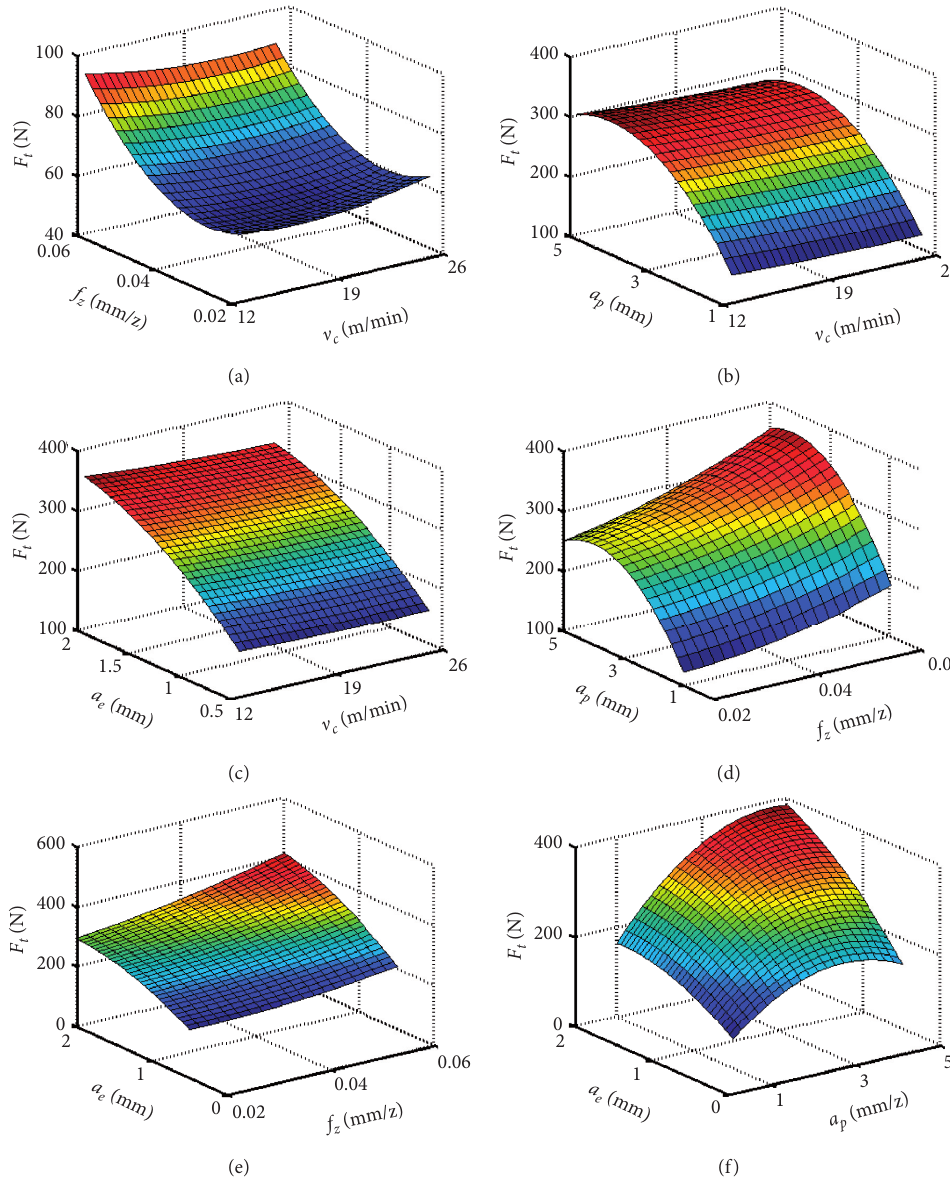
Figure 3: 3D response surfaces on F